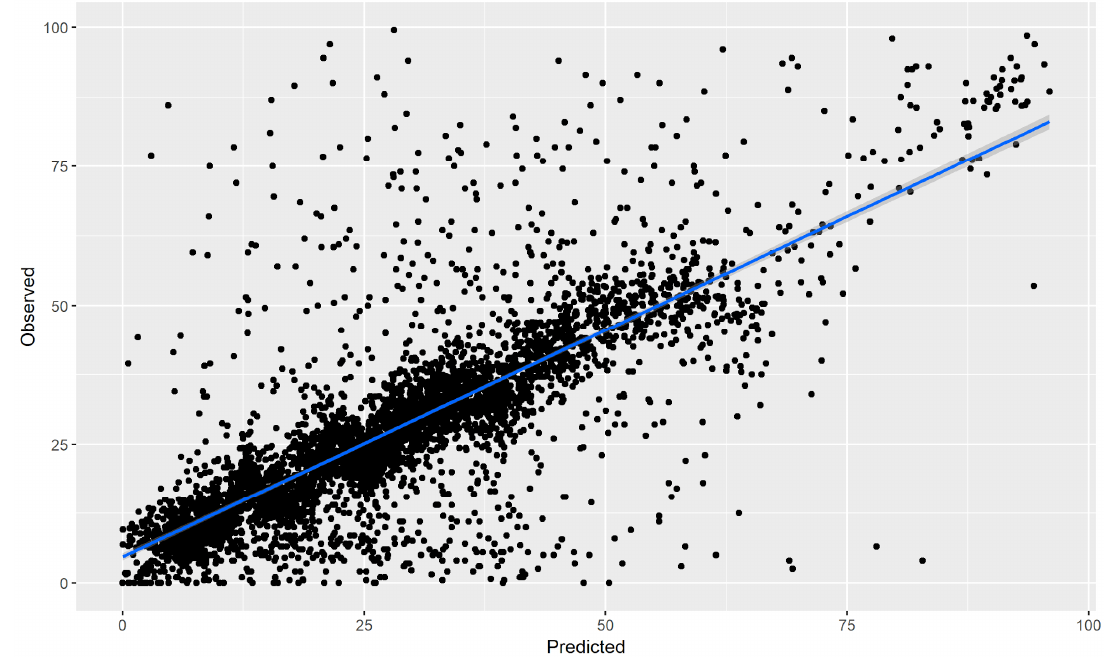
Figure 4. This plot depicts the predicted and observed values for the hourly depressed mood for the entire sample. For plotting, the average of the multiply imputed data points was computed when there was missing data.